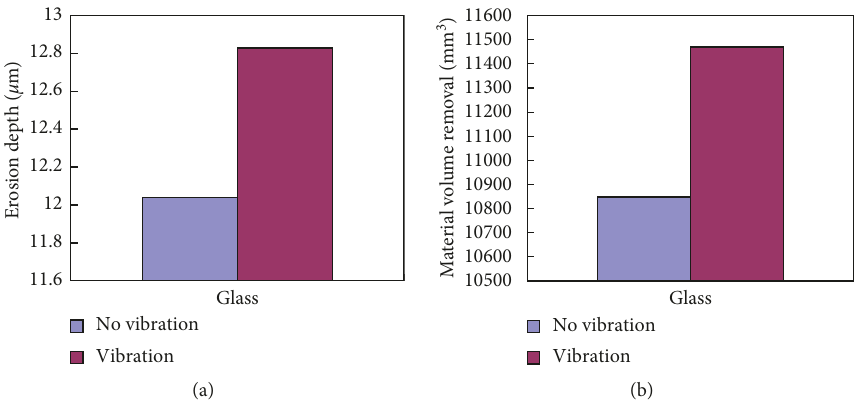
Figure 12: The erosion depth and material removal amount of quartz glass. (a) Erosion depth. (b) Material removal